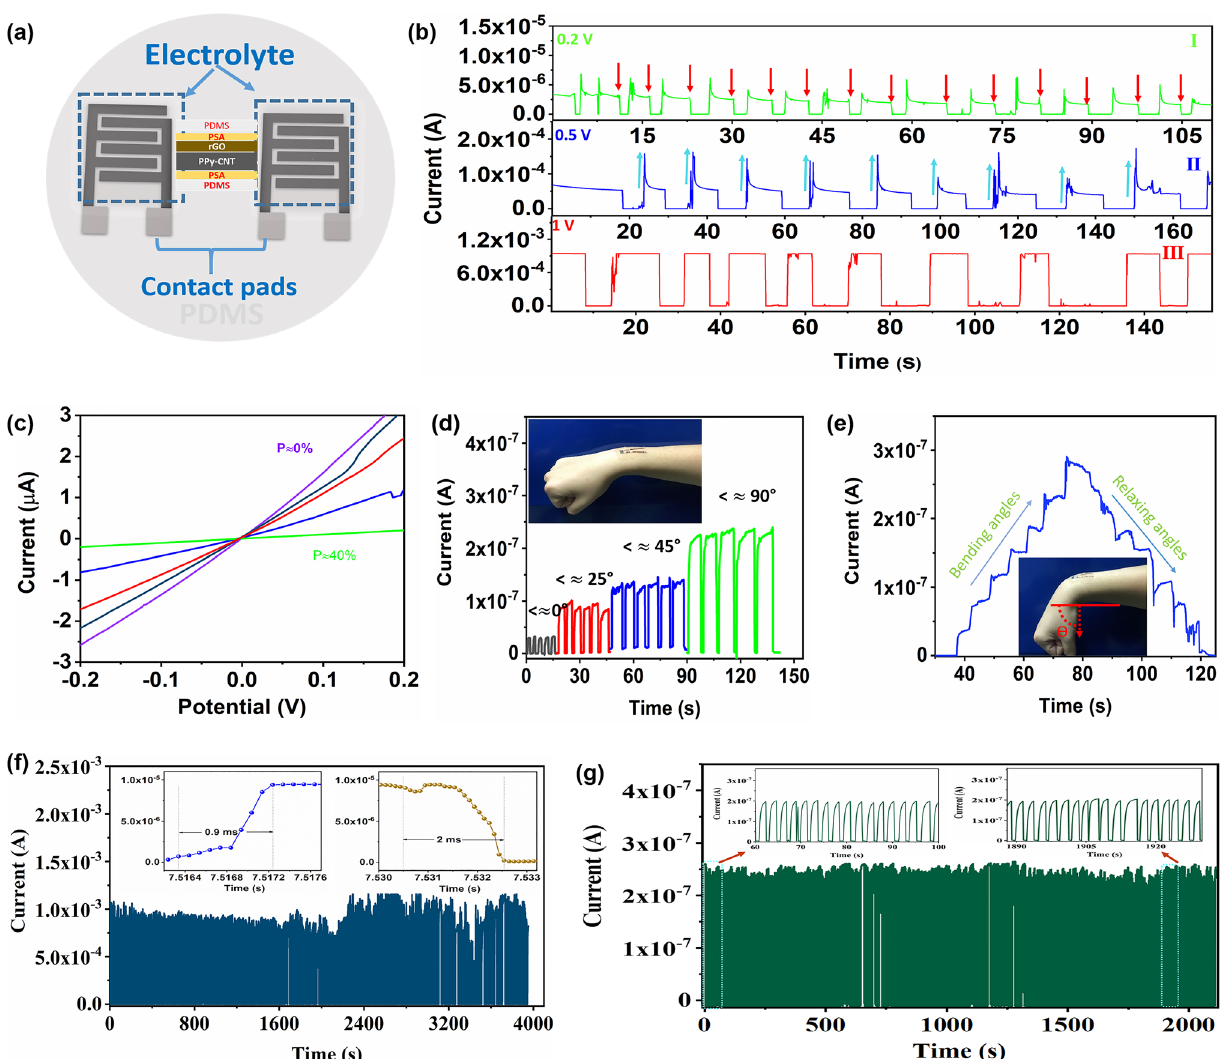
Fig. 6 Electromechanochemical performance of the MSC-derived MSS. a Schematic diagram of flexible MSS. b Variation in current with change in applied stress at different applied voltages for flexible MSS. c Current voltage curves of micro-strain sensor under various applied stresses from 0 to 40% within voltage limits of − 0.2 to 0.2 V. d The response and decay curves at different angles. e The relative change in capacitive current from the gradual wrist bending and relaxing over five bending angles of 10°, 25°, 45°, 75°, and 90°, respectively. f Mechanical test results of cyclic durability for 2500 stress/release cycles at an applied voltage of 1.0 V and a maximum stress of 50 kPa. The inset shows the response time (rise and decay time). g Cyclic durability for 800 bending/release cycles for PSA/PVA microsensor with the maximum bending angle of 90°. The inset shows the first and last few